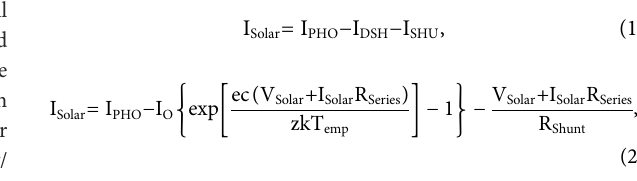
Figure 3. The equations governing the equivalent circuit model of a solar cell are given in Eqs. (1) – (2).